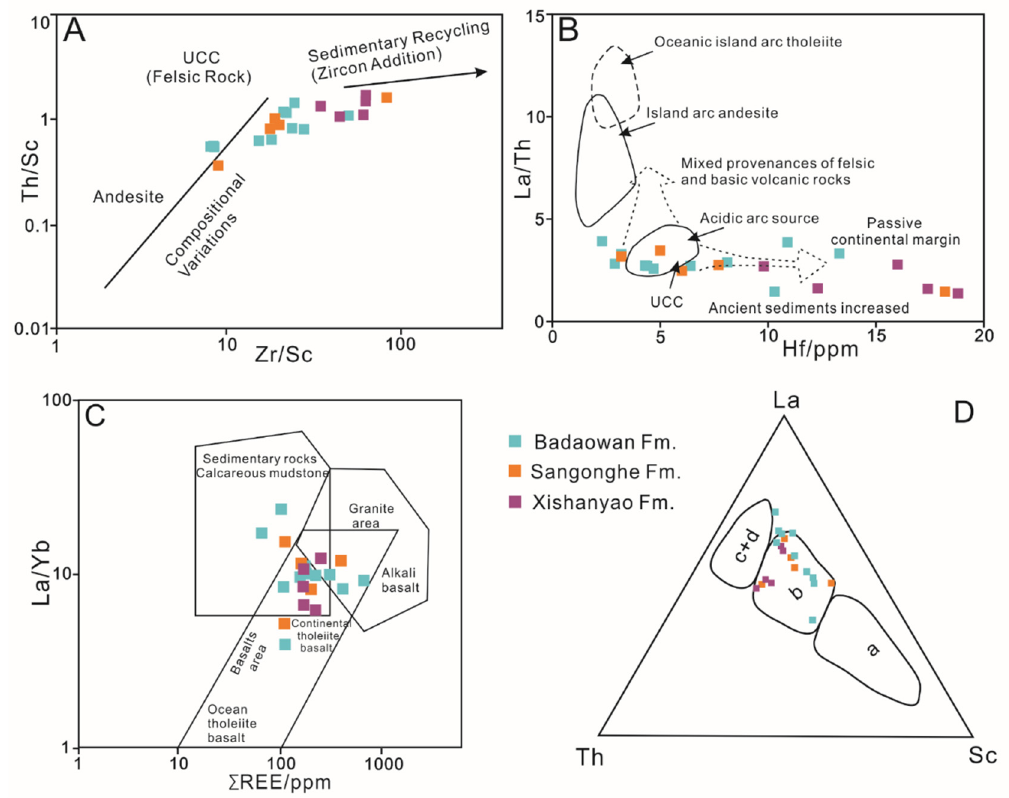
Figure 5. Diagrams of the Yili Basin geochemical results plotted on source rock composition fields: ( A ) Zr/Sc versus Th/Sc plot; ( B ) Hf versus La/Th plot; ( C ) ∑ REE versus La/Yb plot (modified from Liu et al., 2016) [60]; ( D ) Tectonic discrimination plot of La–Th–Sc; a = oceanic island arc; b = continental acidic arc; c = active continental margin; d = passive margin (modified from Bhatia, M.R et al., 1986) [61].